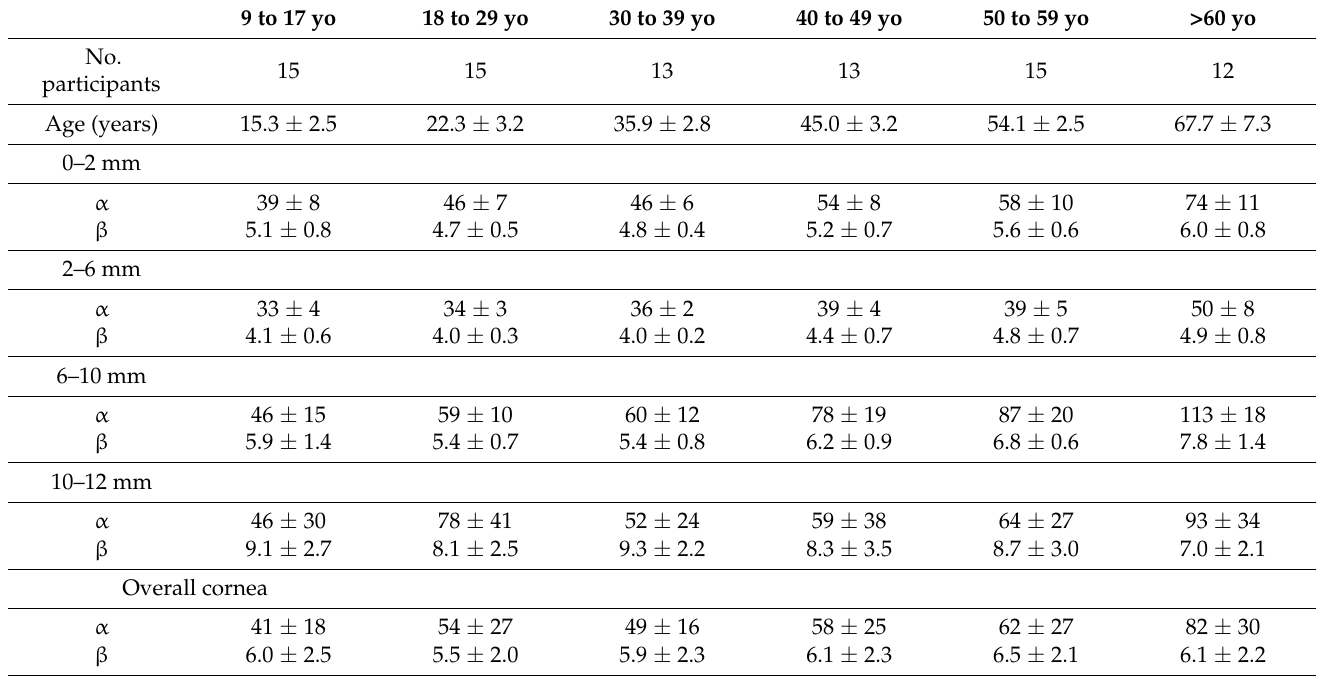
Table 1. Group mean values ± standard deviation of parameters α and β , expressed in arbitrary units, in different corneal regions, for different age groups. Data for left eye